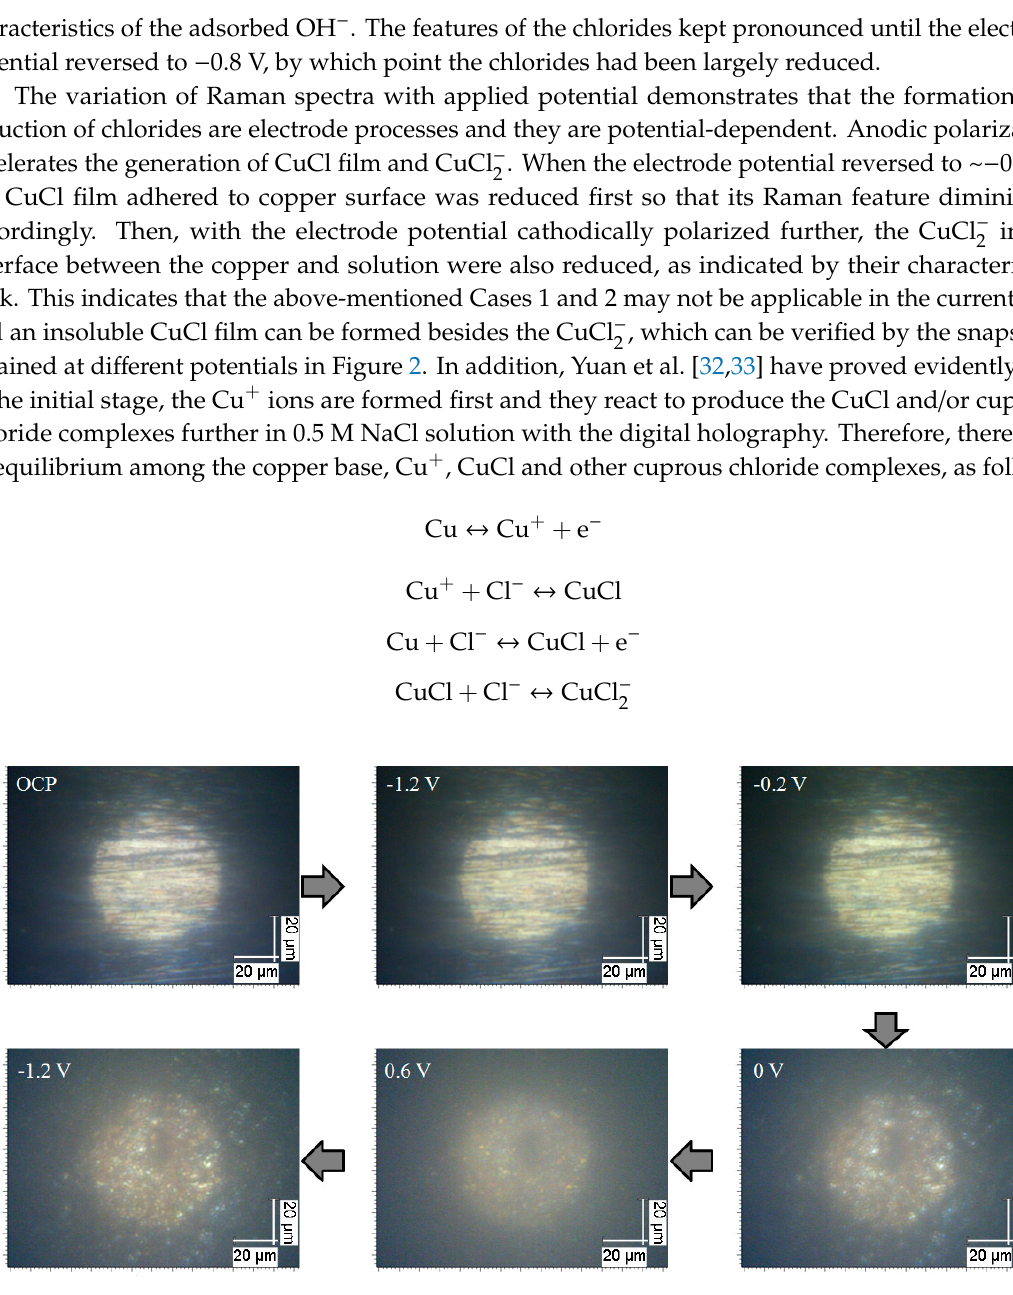
Figure 2. Snapshots of the copper surface in neutral 3.5% (wt.) NaCl solution at OCP and with applied potential varying from − 1.2 to 0.60 V and then reversing to − 1.2 V, which shows that a porous film was formed on copper surface with the electrode potential polarized to about 0 V and it was reduced after the potential reversed to − 1.2 V.